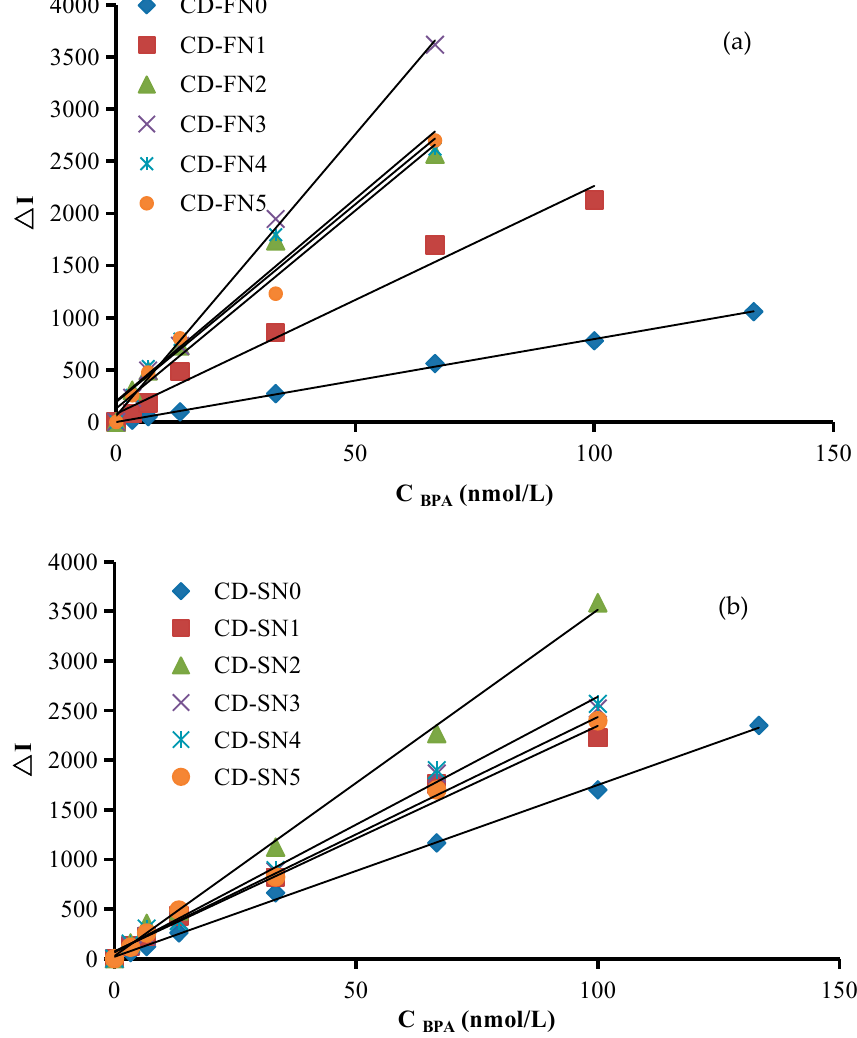
Figure 6. Working curves for the SERS determination of Apt–CD–AgNO 3 –TSC–BPA: ( a ) the solution of 6.67 nmol/L Apt + 3.33–133.33 nmol/L BPA + CD-FN + 1.33 mmol/L AgNO 3 + 4.67 mmol/L TSC + 3.33 × 10 − 7 mol/L VBB + 0.02 mol/L NaCl; ( b ) the solution of 10.00 nmol/L Apt + 3.33–133.33 nmol/L BPA + CD-SN + 1.33 mmol/L AgNO 3 + 4.67 mmol/L TSC + 3.33 × 10 − 7 mol/L VBB + 0.02 mol/L